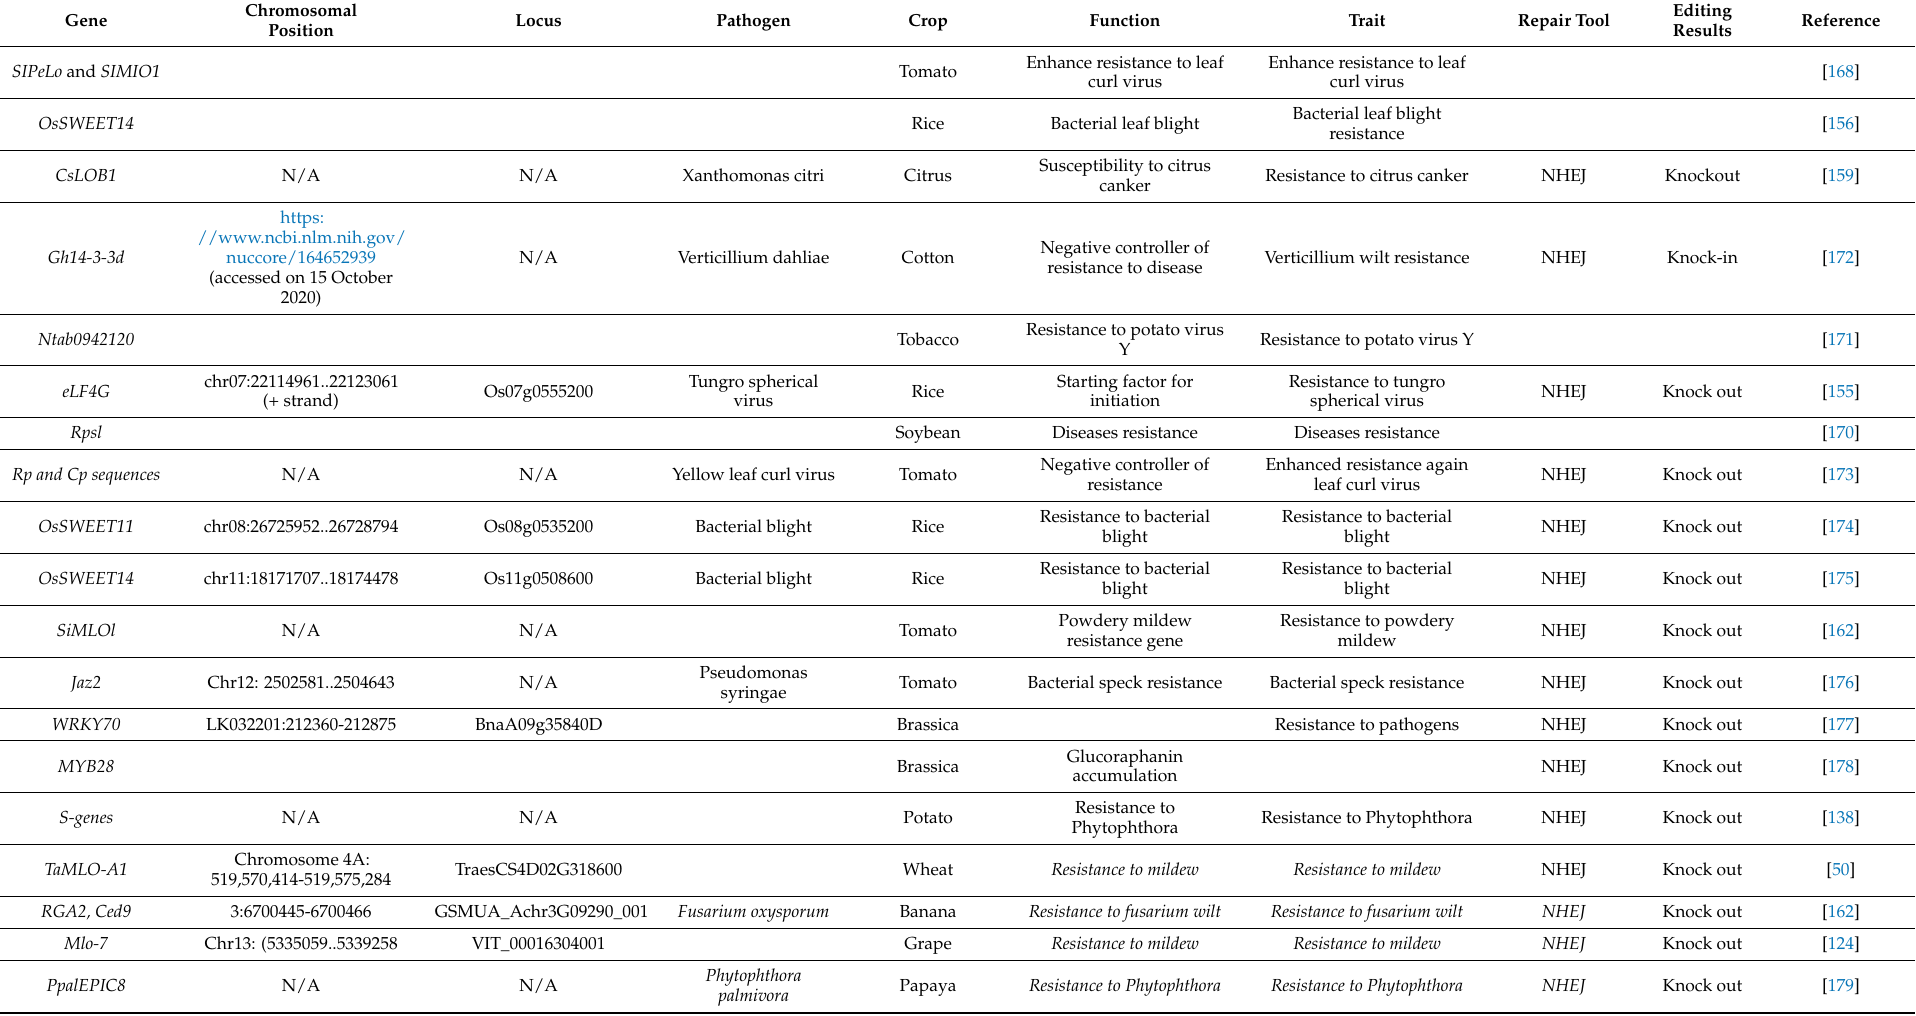
Table 5. A list of diseases resistant crops varieties made by using